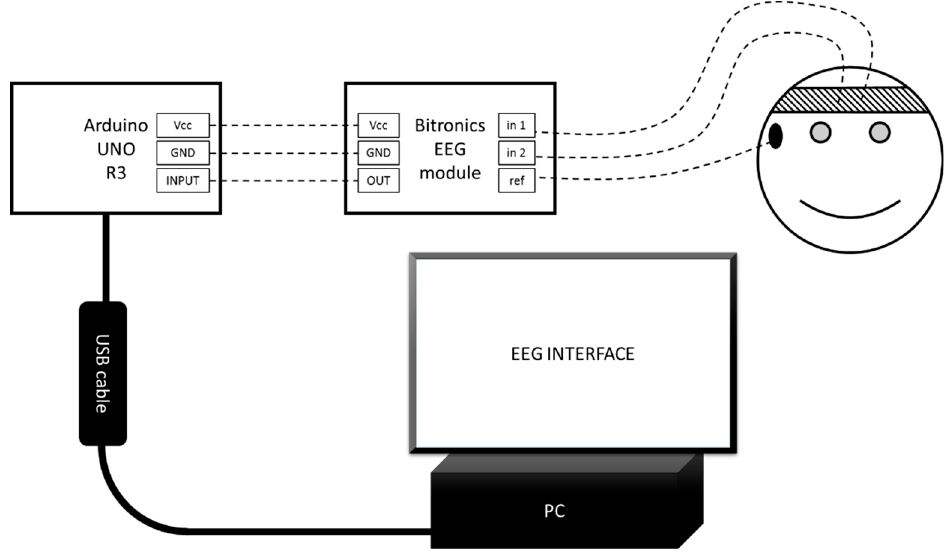
Figure 6. Schematic diagram of the brain computer interface (BCI).